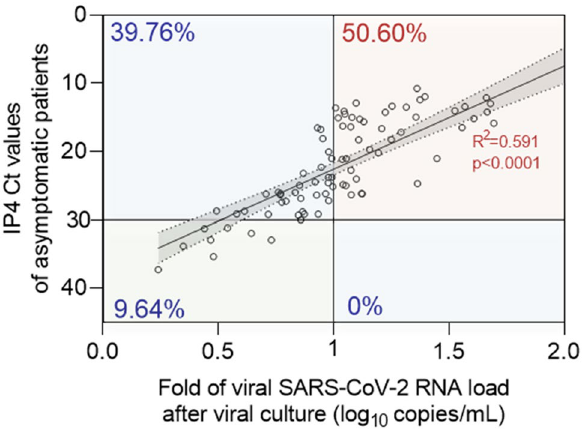
Figure 2. Detection of viable SARS-CoV-2 particles in upper respiratory tract of 83 COVID-19 asymptomatic adult patients. Linear regression curve between IP4 Ct values in COVID-19 asymptomatic patients and fold of viral SARS-CoV-2 RNA load level increase after 96 h viral culture on Vero cells (log10 copies/mL) (R 2 = 0.591, P < 10 –4 ) (n = 83). Fold values greater than 1 were considered as representative of a viral RNA replication